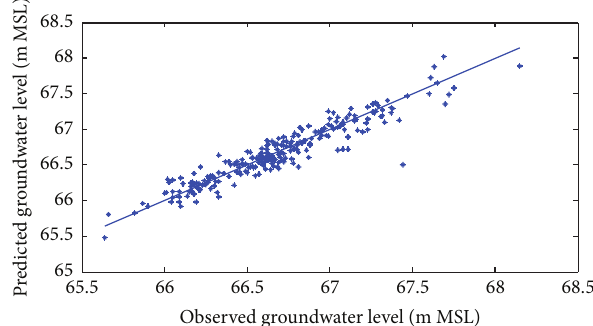
Figure 16: Scatter plots of observed and predicted groundwater levels using an ANFIS model (Lp